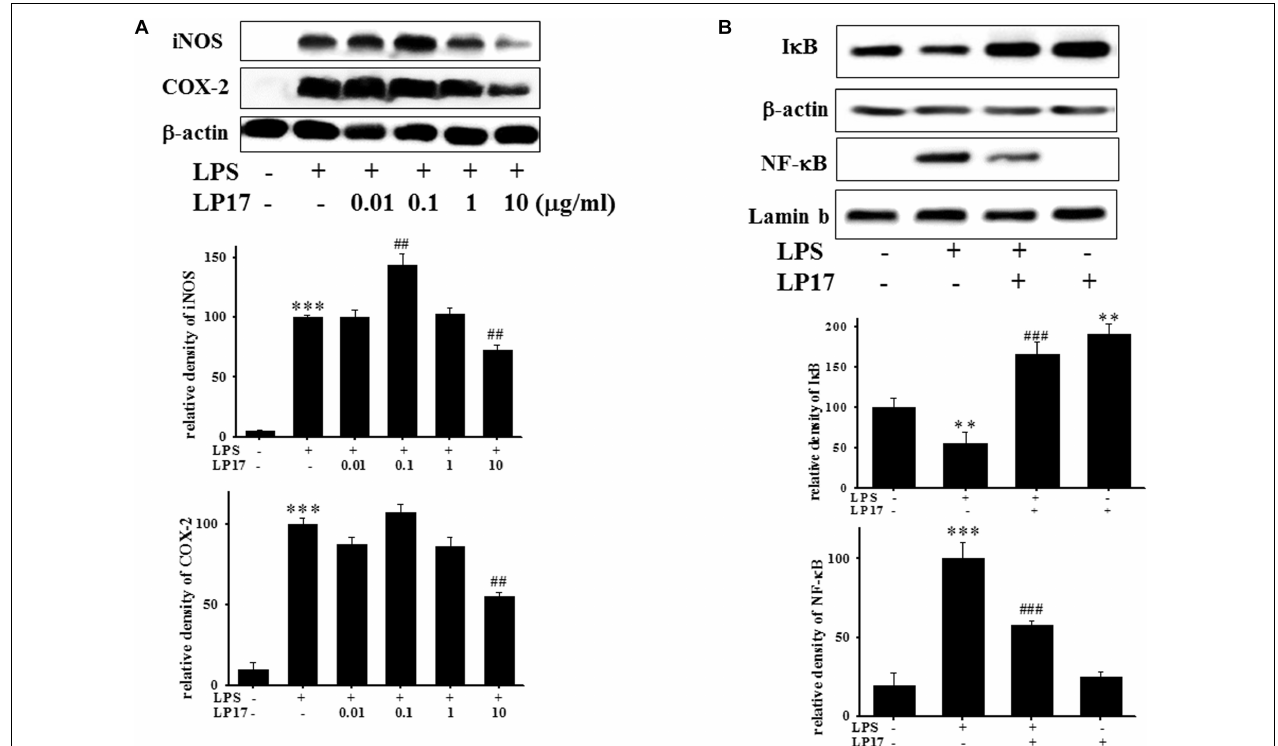
FIGURE 2 | The treatment of LP17 inhibited LPS-induced upregulation of expressions of proinflammatory cytokines iNOS, COX-2, I κ B, and NF- κ B protein in LPS-stimulated BV-2 murine microglial cell line ( n = 4/group). (A) Western blotting for iNOS, COX-2 expression after treatment of BV-2 microglial cells with 0.01, 0.1, 1, and 10 µ g/ml LP17 plus 100 ng/ml LPS for 16 h, showed that 10 µ g/ml LP17 significantly inhibited LPS-induced increase in iNOS and COX-2 protein expressions. (B) Western blotting for I κ B, and nuclear NF- κ B after treatment of BV-2 microglial cells with 10 µ g/ml LP17 plus 100 ng/ml LPS for 6 h, showed that LP17 significantly reversed the LPS-induced downregulation of I κ B protein expression and significantly attenuated the LPS-induced upregulation of nuclear NF- κ B protein expression. The bars represent the mean ± SEM. The data were analyzed using two-way ANOVA. ∗∗ P < 0.05; ∗∗∗ P < 0.001 versus the control group; ## P < 0.05, ### P < 0.001 versus the LPS